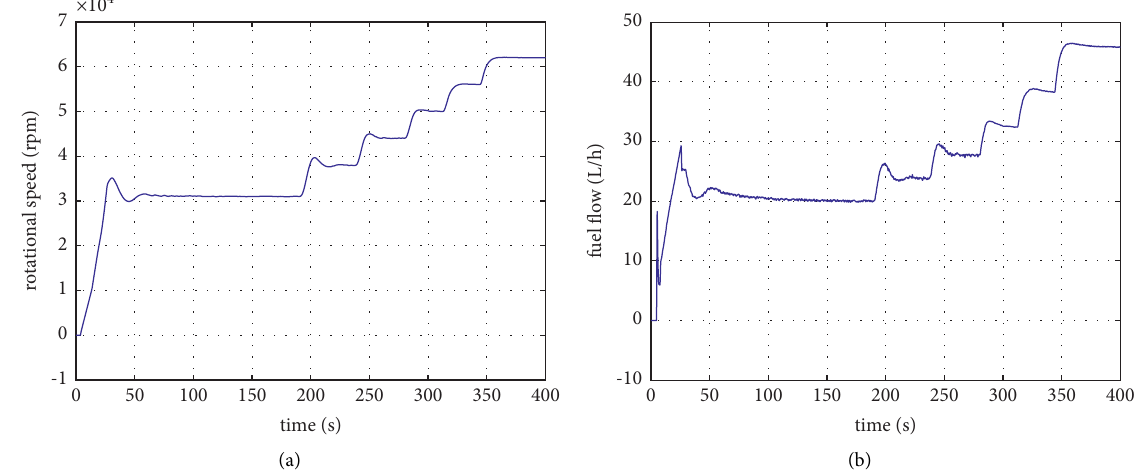
Figure 3: Engine starting experimental results. (a) Spool rotate speed. (b) Fuel flow.